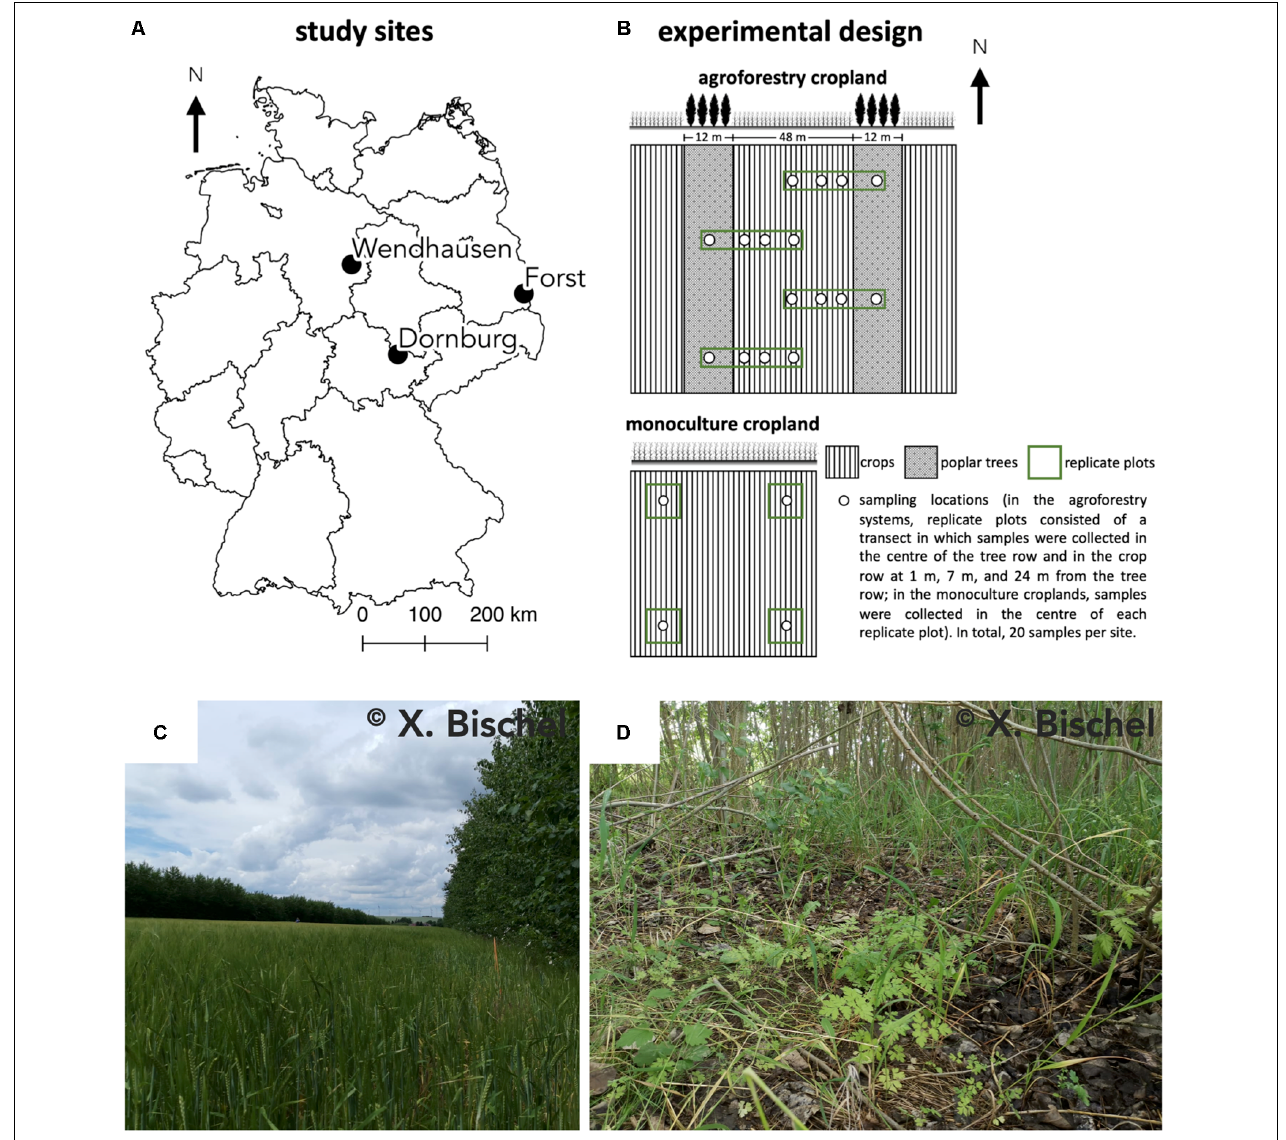
FIGURE 1 | (A) Locations of the three study sites in Germany, (B) the experimental design at each site, (C) the alley-cropping agroforestry system, and (D) the herbaceous layer under the trees of the agroforestry system at the Dornburg site. Calcaric Phaeozem soil in Dornburg, Gleyic Cambisol soil in Forst, and Vertic Cambisol soil in